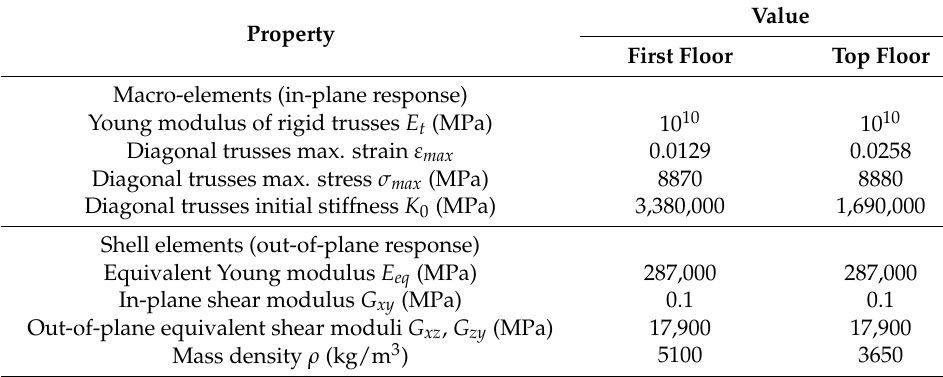
Table 7. Properties of the shell elements (thickness = 36 mm) and macro-elements representing the diaphragms retrofitted with plywood panels in configuration